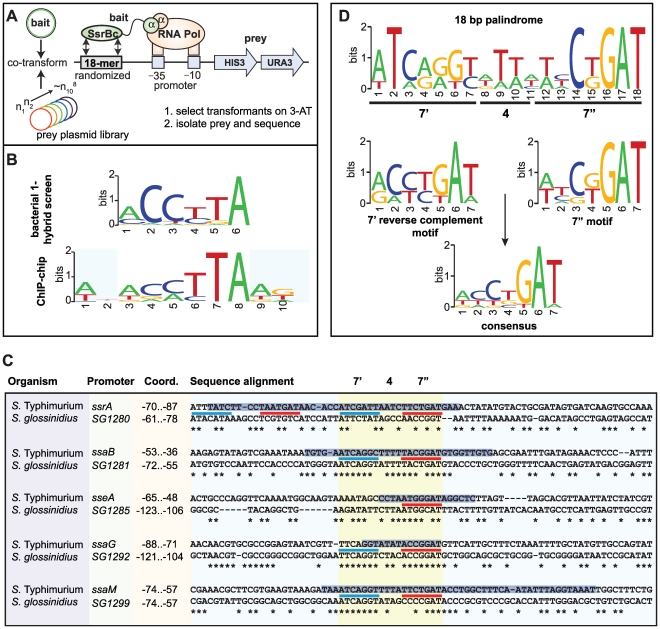
Identification of a conserved palindrome in S. Typhimurium SPI-2 and S. glossinidius SSR-3 promoters.(A) Schematic representation of the bacterial one-hybrid screen for functional SsrB binding sequences. (B) Motif logos generated independently from the bacterial one-hybrid screen and ChIP-on-chip data show similar but degenerate consensus along 6 nucleotides. (C) Aligned promoter regions from the S. Typhimurium SPI-2 island and S. glossinidius SSR-3 island containing the putative SsrB DNA recognition palindrome. Coordinates indicate position of the conserved palindrome with respect to the translational start site of the downstream gene. The 7′-4-7″ tail-to-tail palindrome sequences are underlined in blue (7′ site) and red (7″ site), aligned and highlighted in yellow. Asterisks indicate conserved nucleotides between S. Typhimurium and S. glossinidius. The positions of SsrB footprints protected from DNase1 [25],[26] are shown as black text highlighted with a blue horizontal bar. (D) Consensus motif logos for the palindrome sequences from the SPI-2 promoters shown in (C).